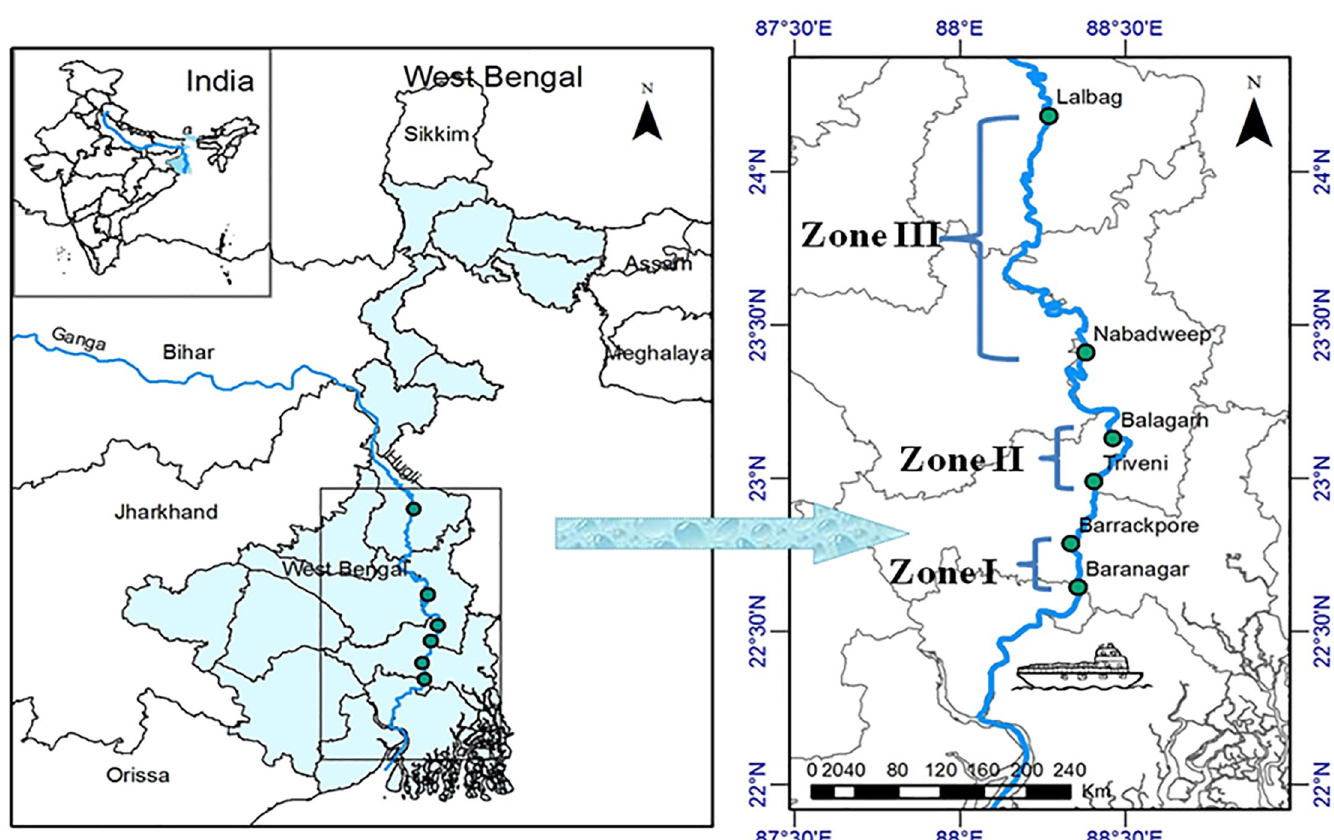
Fig 1. Sampling locations in Bhagirathi-Hooghly river